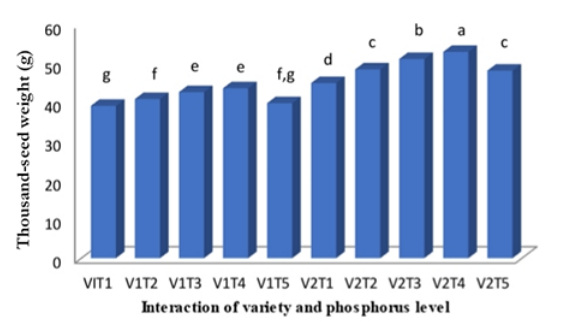
Figure 5 Interactive effect of varieties and different levels of phosphorus on 1,000-seed weight in